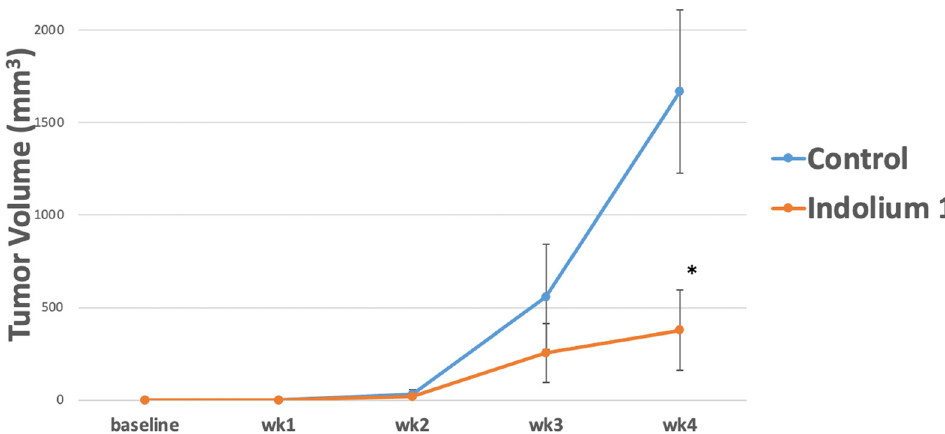
Figure 2. Tumor Growth in control versus Indolium 1-treated mice. Indolium 1 treatment results in reduced tumor volume over 4 weeks. Mice were inoculated with LM36R, a vemurafenib-resistant melanoma cell line, at 1 × 10 6 cells/mouse. Mice were then treated with Indolium via IP administration three times a week at a concentration of 3 mg/kg/dose. Tumor growth was compared to control vehicle (sterile water). Results indicate a possible reduction in tumor growth over the period of observance. (N = 5/group, p -value = 0.03) at week 4. * = Statistically significant reduction in tumor volume compared to control ( p < 0.05)